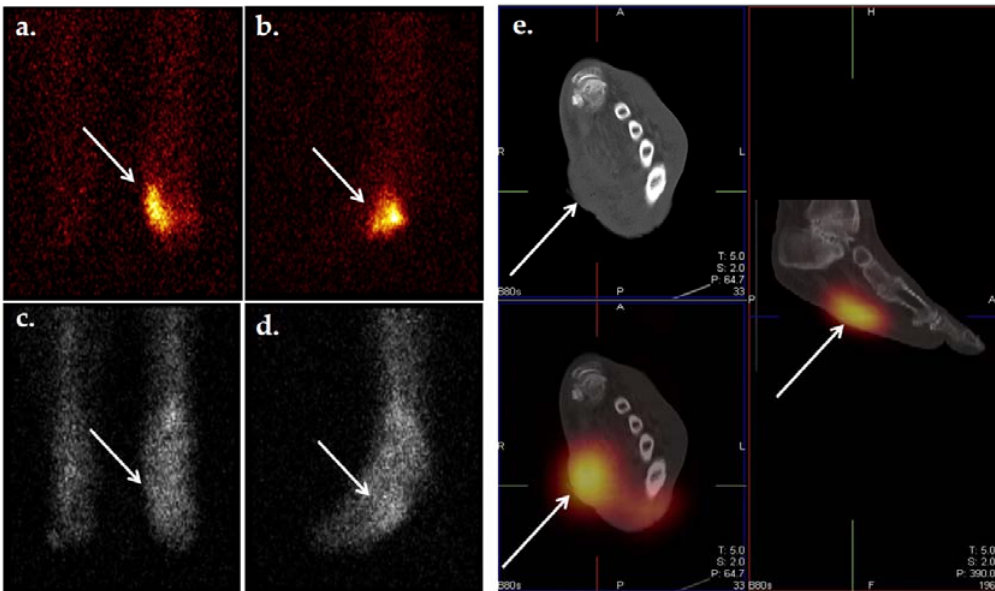
Figure 8. Dual tracer imaging using 111 n-WBC and 99m Tc-sulfur colloid. Planar 111 In-WBC ( a , b ) and 99m Tc-sulfur colloid ( c , d ) images from a 62-year-old male with diabetes with a left foot abscess. There is spatial and intensity discordance in activity from the radionuclides. Anterior ( a ) and lateral ( b ) 111 In-WBC images show focus of increased activity in the left mid foot. Anterior ( c ) and lateral ( d ) 99m Tc-sulfur colloid images show diffuse activity throughout the mid and hind foot, suggesting the development of Charcot foot. Axial and sagittal 111 In-WBC SPECT/CT ( e ) localized activity to an abscess in the plantar aspect of the left mid foot. Osteomyelitis was excluded.